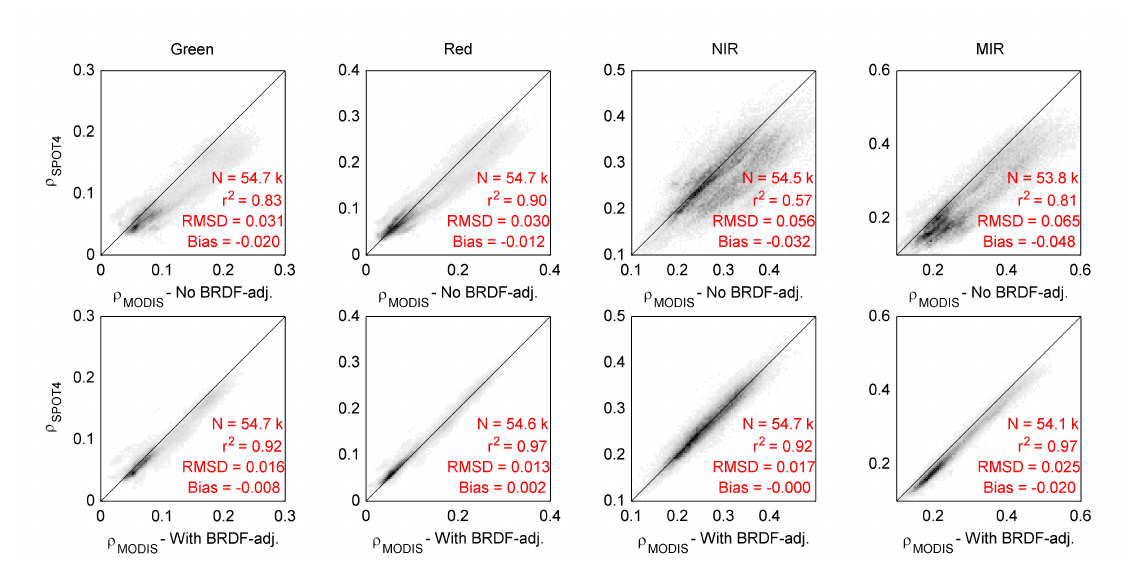
Figure 11. Comparison of SPOT-4 (Take 5) surface reflectances with MODIS reflectances averaged at 5-km resolution, for all SPOT-4 (Take 5) acquisition dates; top, before directional correction; bottom, after directional correction. From left to right, the columns correspond to the green, red, NIR and SWIR